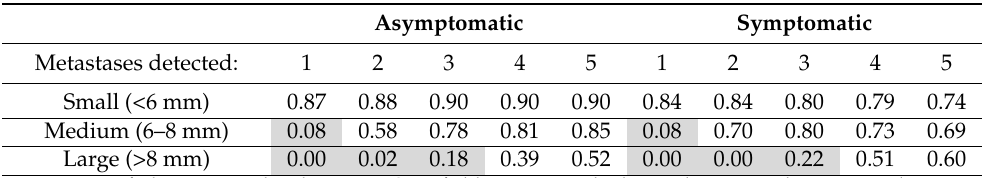
Table A14. Proportion of oligo+ within patients with detected oligo-metastases in the redefinition of oligo metastases to 1–5 metastases scenario.